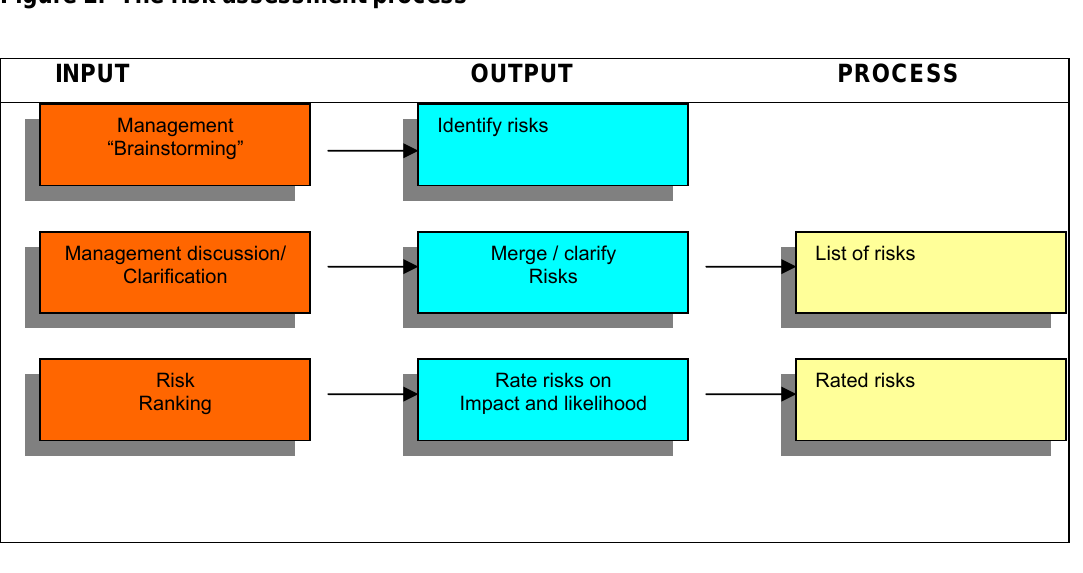
Figure 2: The risk assessment